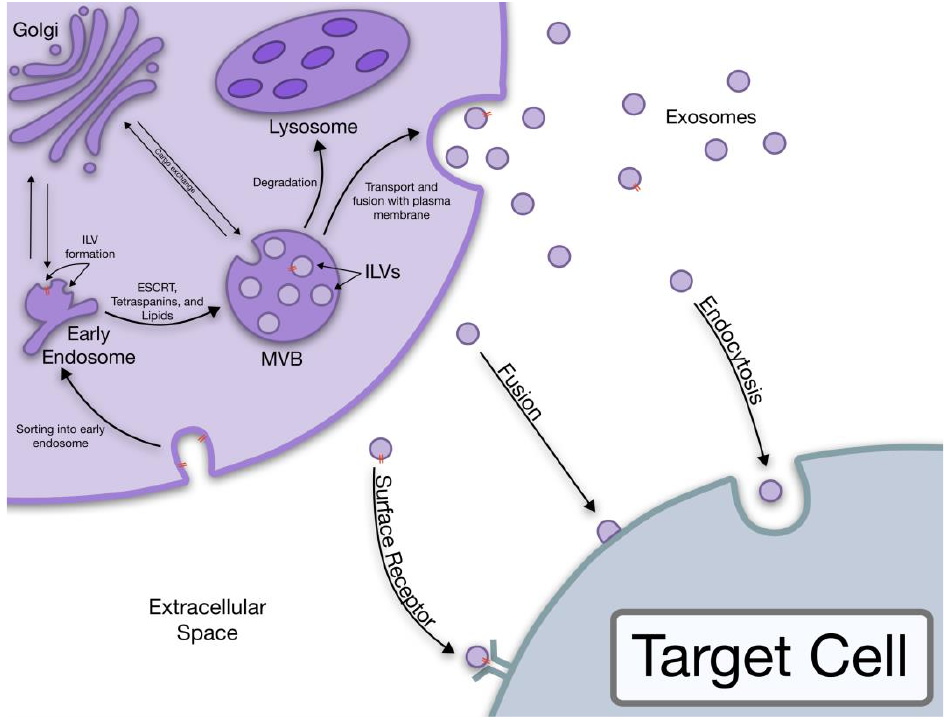
Figure 1. The biogenesis of exosomes all the way to the uptake by target cells.